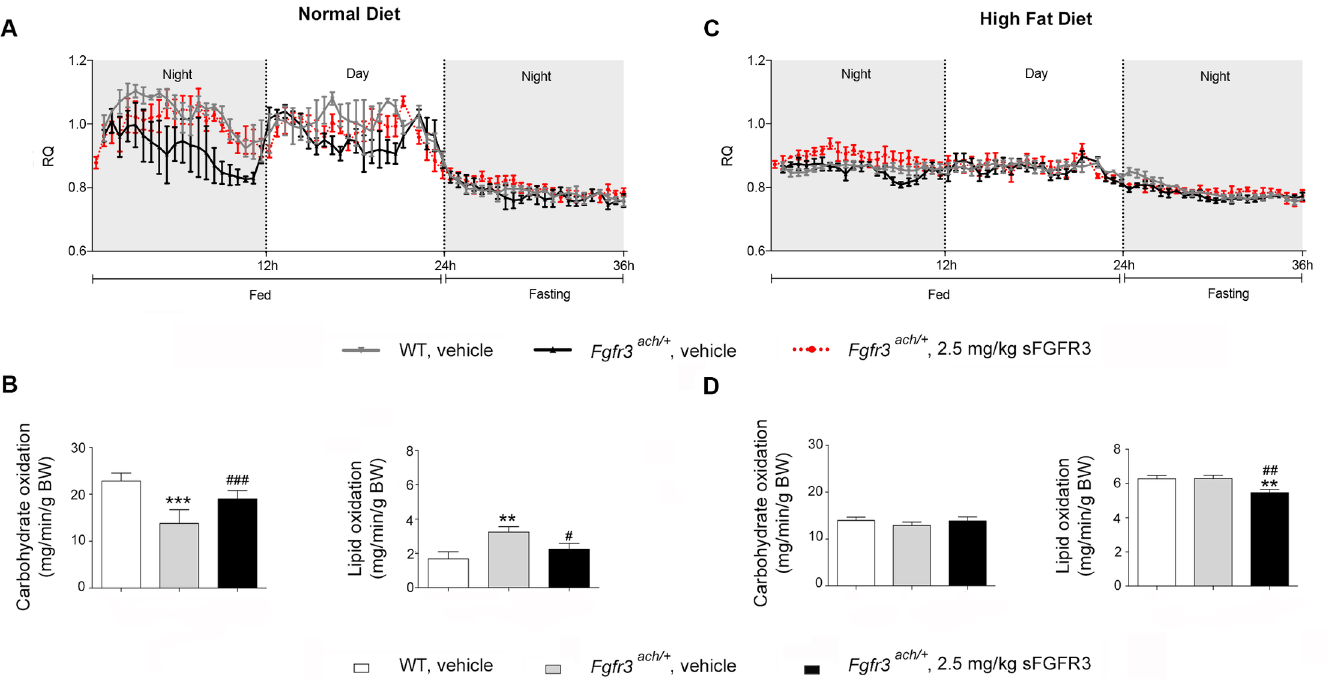
Fig 5. Untreated transgenic Fgfr3 ach/+ mice draw essentially their energy from lipids. Basal respiratory quotient (RQ = VCO 2 /VO 2 ) during night or day fasting and feeding periods following 10 weeks of ND ( A ) or HFD ( C ) challenge. Basal carbohydrate and lipid oxidation in WT and Fgfr3 ach/+ ND ( B ) or HFD ( D ) challenged mice. Data are represented as mean ± SD (n = 8–10 mice to each group). Data followed normal distribution. (cid:3)(cid:3) p < 0.01, (cid:3)(cid:3)(cid:3) p < 0.001 versus vehicle-treated WT, # p < 0.05, ## p < 0.01 versus vehicle-treated Fgfr3 ach/+ ; Student’s t test.